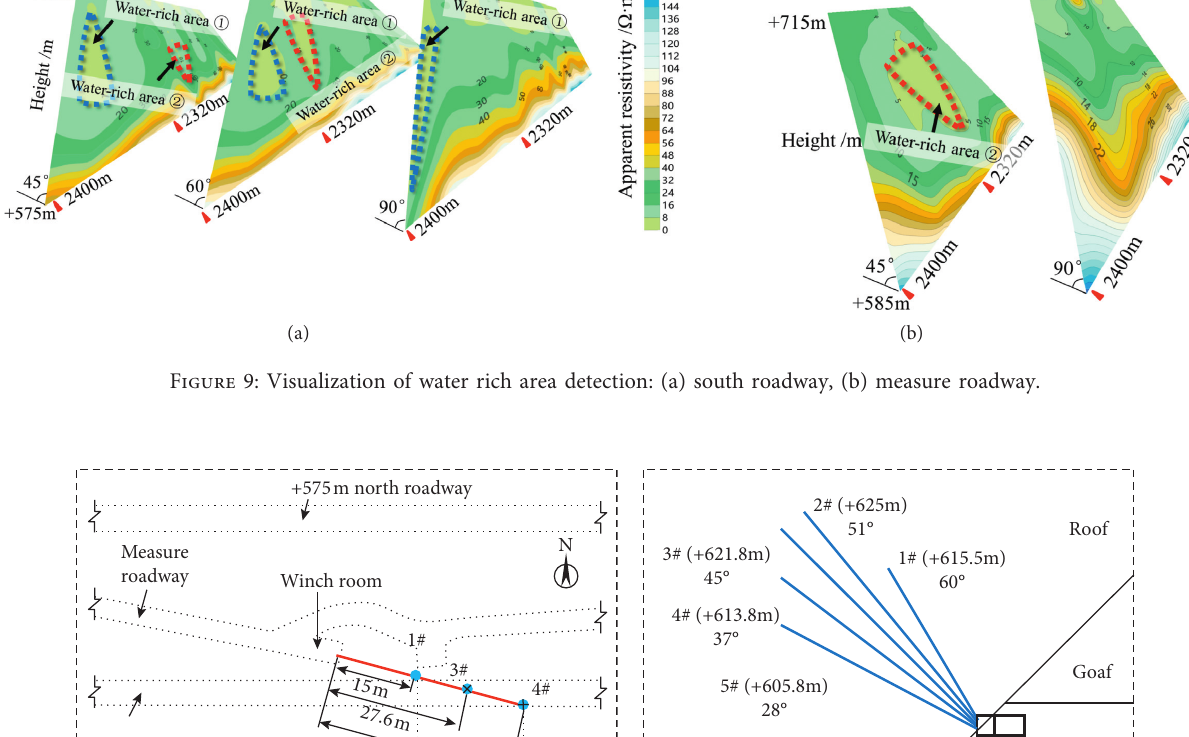
Measure roadway